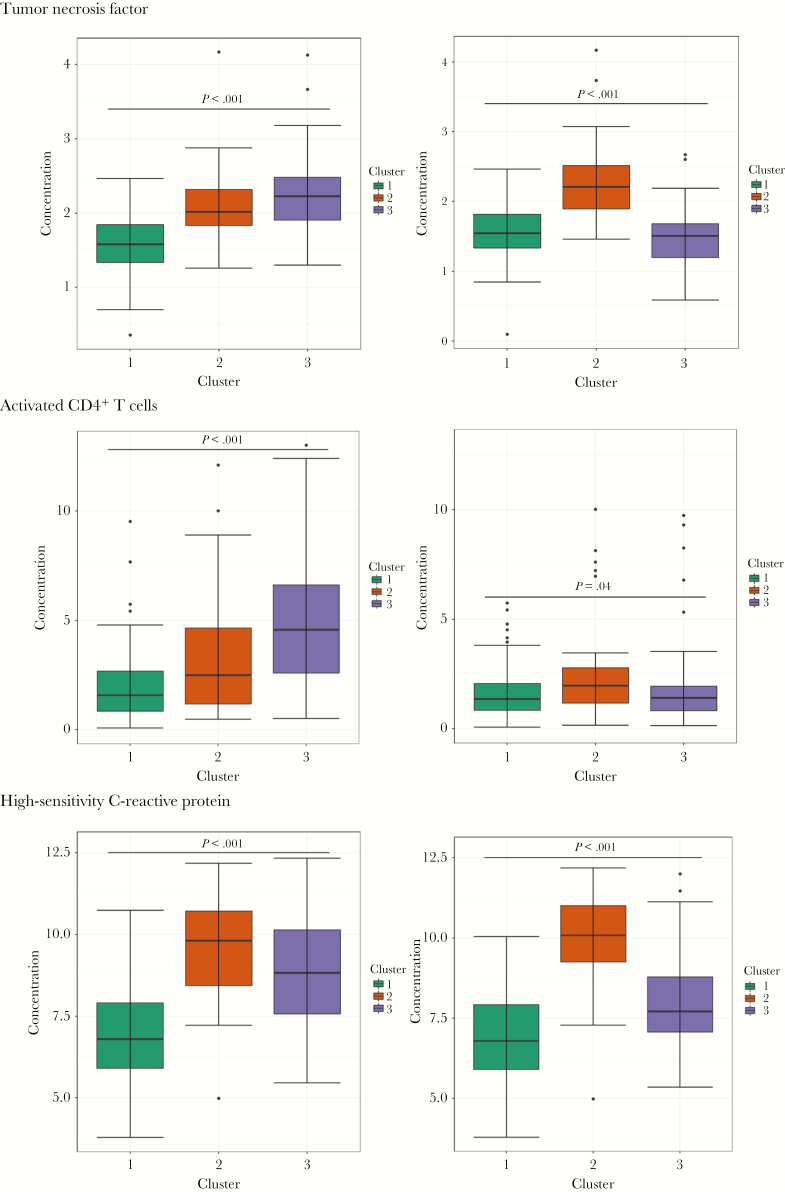
Box plots of log concentrations of tumor necrosis factor, activated CD4+ T cells (defined as, T cells double positive for HLA-DR and CD38), and high-sensitivity C-reactive protein, by cluster group, at baseline (week 0; left column) and week 96 (right column). P values were determined by the Kruskal-Wallis test. For concentrations of the complete set of biomarkers, see Supplementary Figure 5.